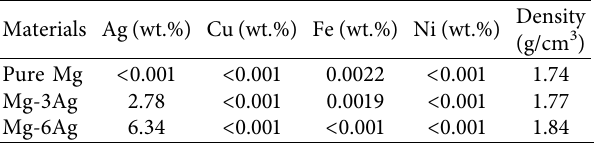
Table 1: Mass composition and average density of pure Mg and Mg-Ag